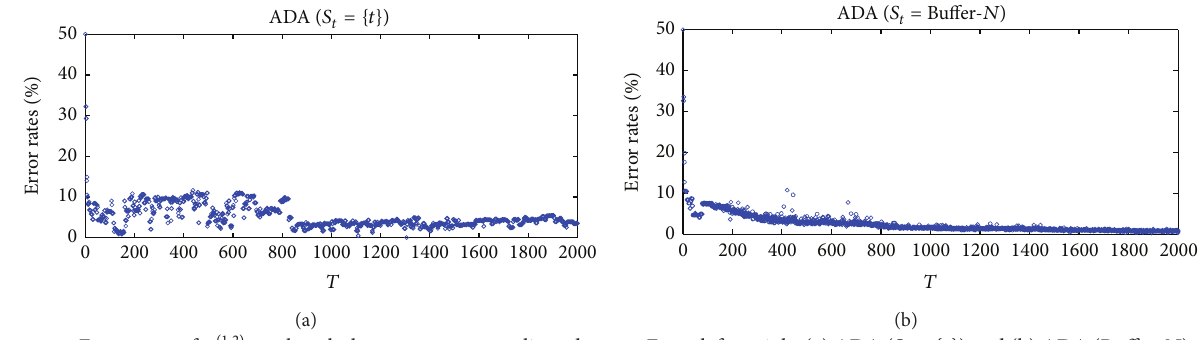
Figure 7: Error rates of 𝜔 (1,2) 𝑡 on the whole two-moons-two-lines data set. From left to right (a) ADA ( 𝑆 𝑡 = {𝑡} ) and (b) ADA (Buffer- 𝑁 ). The error rate of 𝜔 (1,2) 𝑡 has a downward trend, but it is not always decreasing during the online coregularization process. Table 3: Mean test error rates on the web page data set. The error rates are reported for three different sparse approximations. For gradient ascent, we choose a decaying step size 𝜌 𝑡 = 0.1/√𝑡 . The result shows that our derived online co-regularization algorithms achieve test accuracy comparable to offline co-regularization (CoLapSVM). Online co-regularization